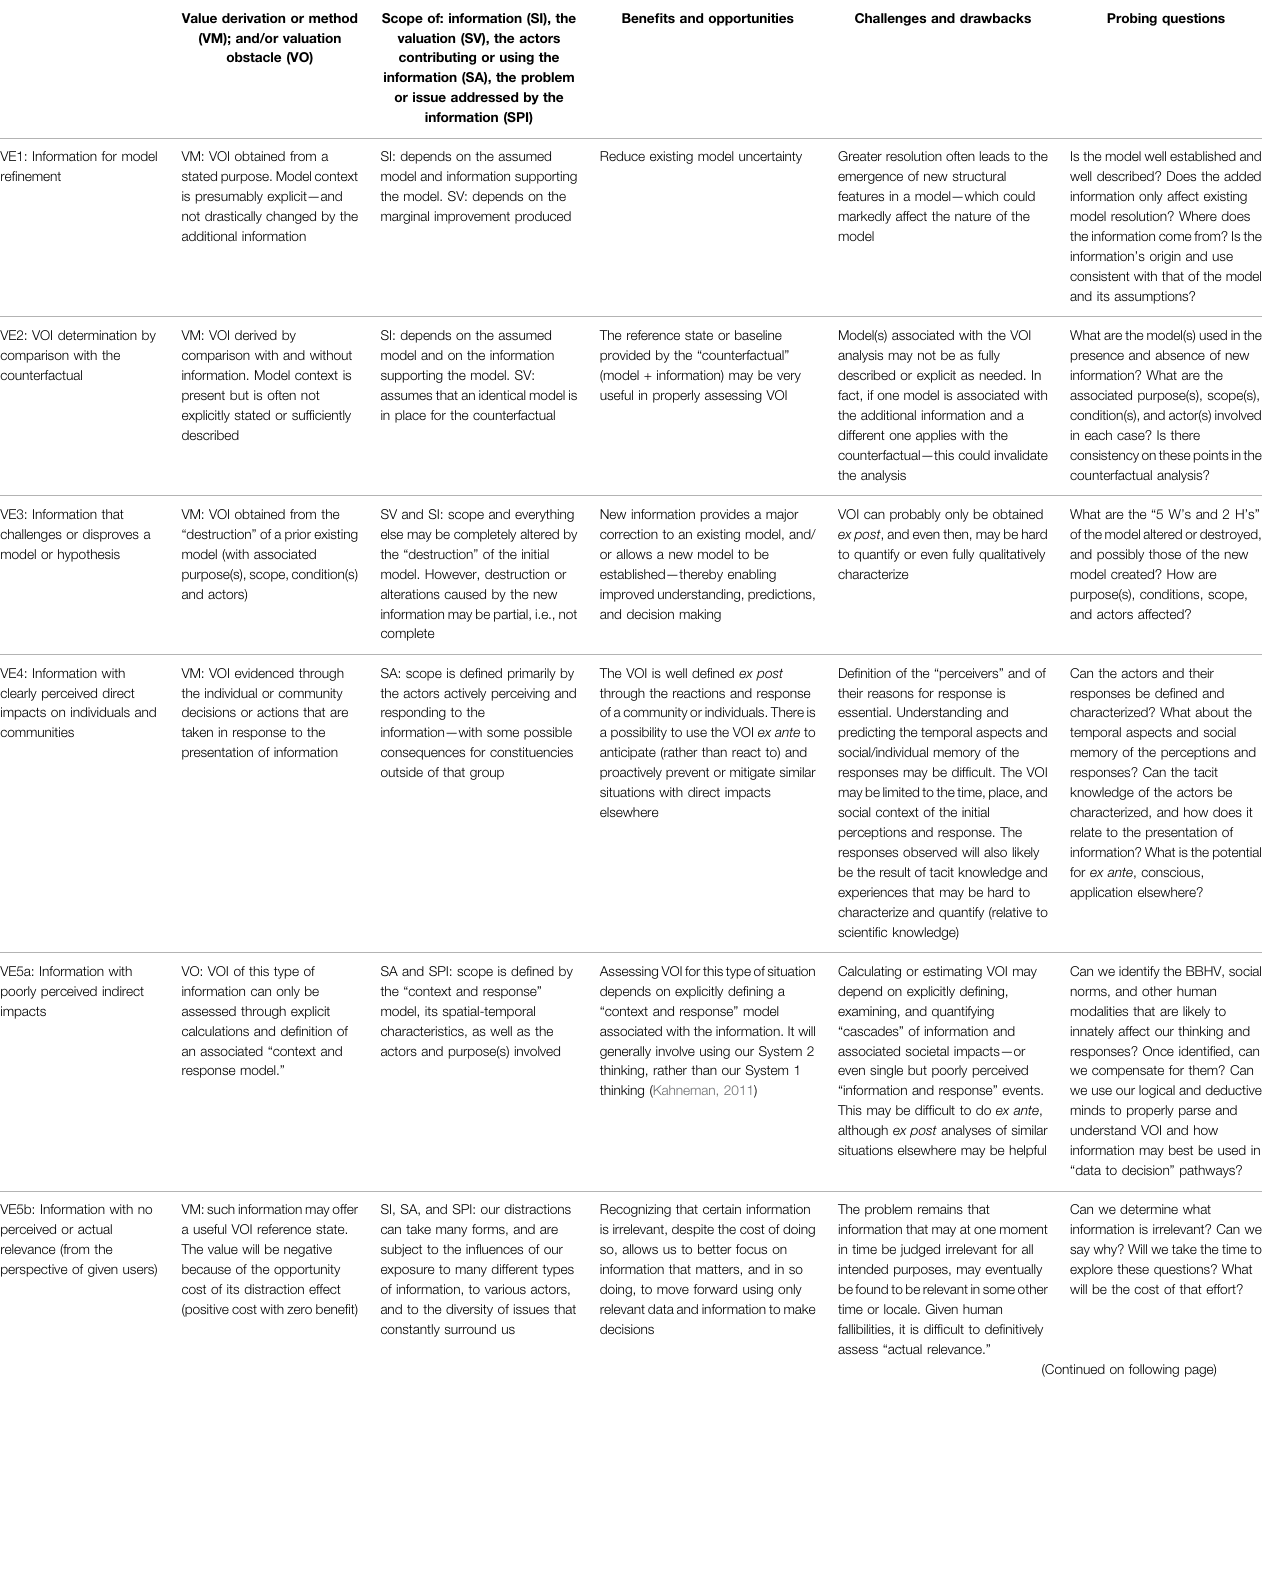
TABLE 1 | Summary of fi fteen “ value explorations ” of VOI methodologies and of behavioral and social factors in fl uencing information and VOI. See accompanying article by Glynn et al. (2022, this issue) for complementary analyses. Value derivation or method Scope of: information (SI), the (VM); and/or valuation valuation (SV), the actors obstacle (VO) contributing or using the information (SA), the problem or issue addressed by the information